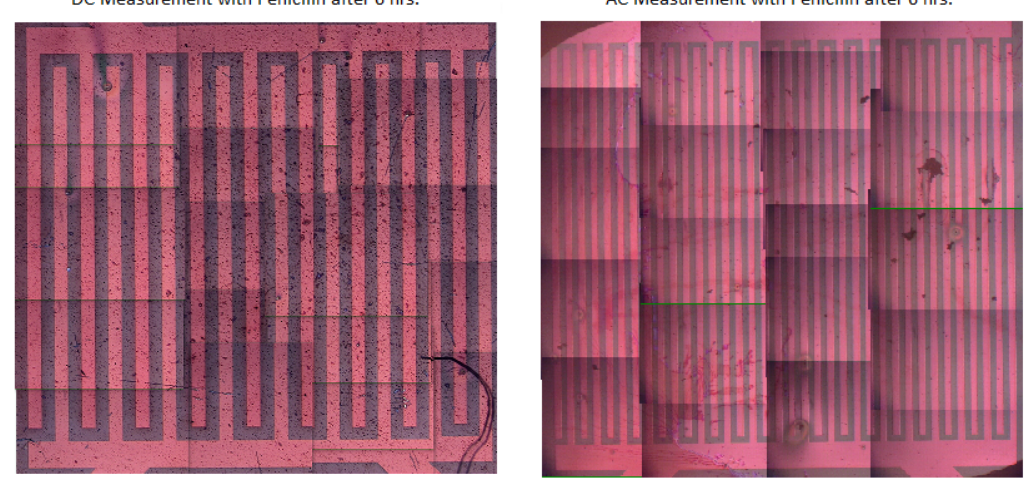
Figure 5. Comparison of DC and AC measurement modes with penicillin solution on top of the transistors after 6 h. The DC measurement resulted in deposits on the transistor degrading it, whereas the transistor was working after the similar measurement was repeated with